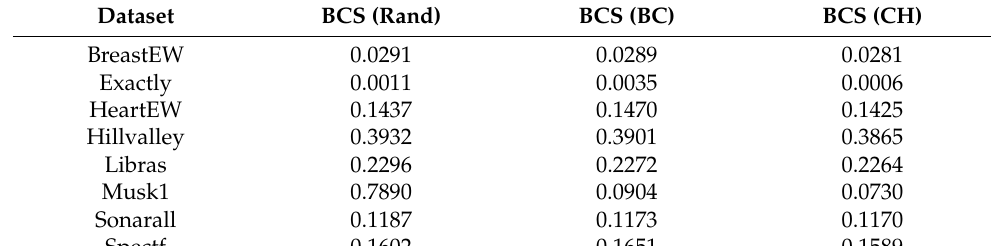
Table 2. Classification error rate of three initialization strategies.